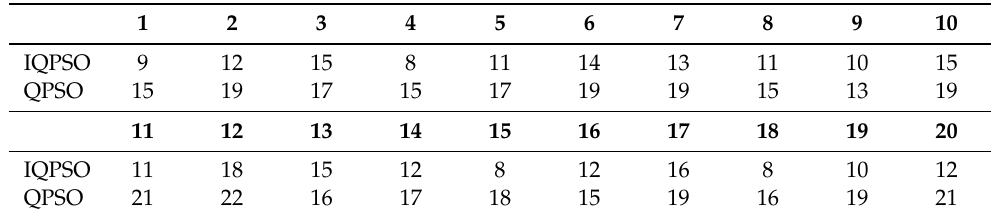
Table 2. Comparison of convergence speed.